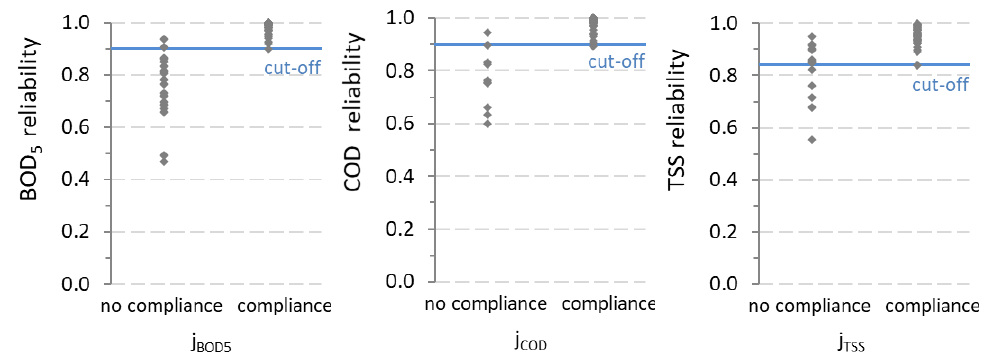
Figure 2. Plant reliability vs. compliance with the EU discharge requirements for urban WWTPs towards BOD 5 , COD, and TSS (5-year data, 16 activated sludge WWTPs). The aggregated results of all WWTPs analyzed during the 5-year period show the minimum reliability was 0.90 for BOD 5 and COD and was 0.84 for TSS. These values are coherent with the maximum number of tests that are allowed to fail the X s in relation with the minimum number of tests carried out. For example, when 12 tests are carried out, 2 tests are allowed to fail the X s , which corresponds to 0.83 compliance; for 52 tests carried out, 0.90 compliance is required. However, a reliability value equal or above these cut-offs could result in a noncompliance if the maximum deviation is exceeded, as shown in Figure 2. The recommendation of Andraka and Dzienis for wastewater treatment plants under 50,000 equivalent population (1 EP = 60 g BOD 5 /d, EU Directive 91/271/EEC) is a minimum reliability of at least 0.94 for all parameters